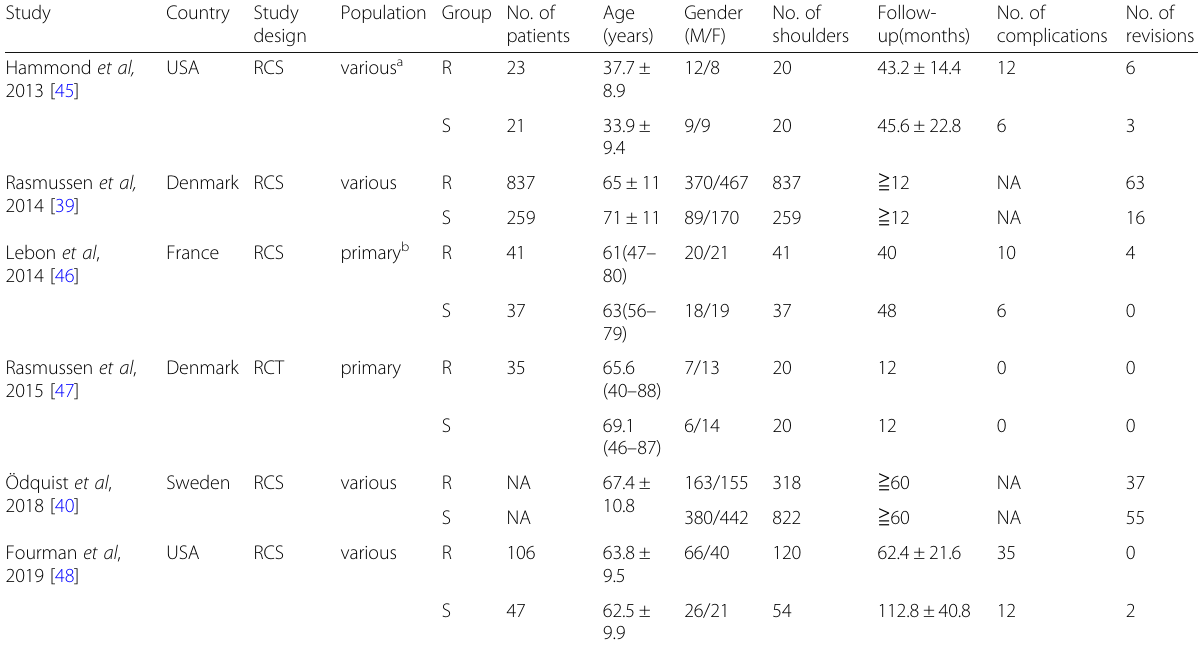
Table 1 The main characteristics of the included studies Study Country Study design